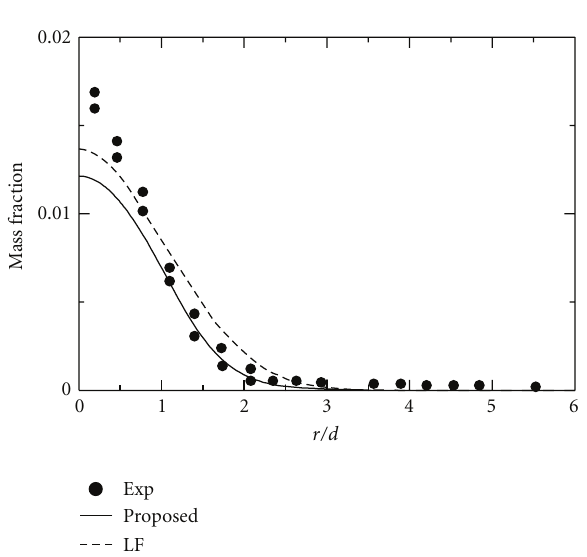
Figure 20: Radial mass fraction of H 2 at x/d = 20.